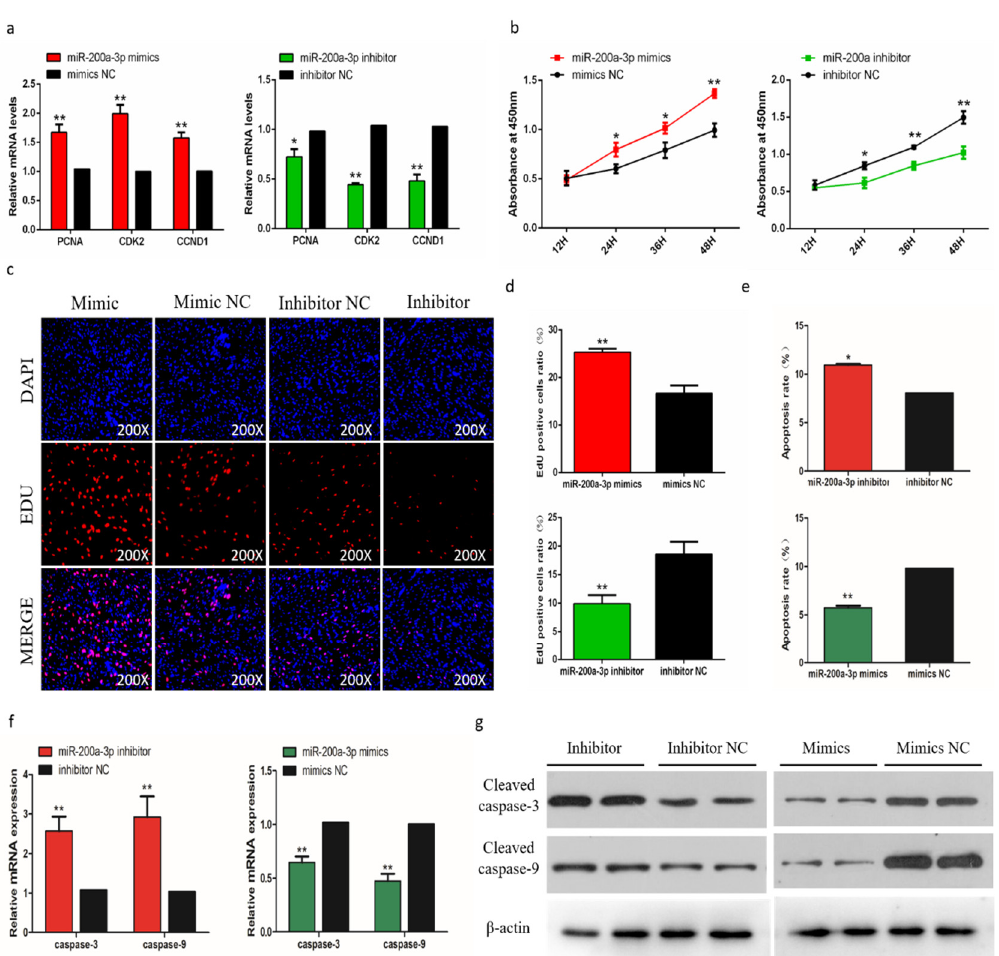
Figure 6. E ff ects of miR-200a-3p on the apoptosis of skeletal muscle satellite cells (SMSCs). ( a ) Detection of mRNA levels of SMSC cell proliferation-related genes after overexpression and inhibition of miR-200a-3p by qRT-PCR. ( b ) Cell Counting Kit-8 (CCK-8) detects SMSCs after overexpression and inhibition of miR-200a-3p. ( c , d ) EdU staining and chicken SMSCs proliferation rate after transfection of miR-200a-3p mimics and inhibitors in SMSCs. The results are shown as an average scanning electron microscope, and the data represent at least three independent analyses. Student’s t-test was used to compare the expression levels between groups. ( e ) Scattergram and the rate of apoptosis in SMSCs transfected with miR-200a-3p mimics or miR-200a-3p inhibitors as analyzed using flow cytometry following staining with annexin V and PI. ( f , g ) Abundance of mRNA and proteins of caspase-3 and caspase-9 in SMSCs transfected with miR-200a-3p inhibitors and miR-200a-3p mimics as determined by the use of qPCR and Western blot analysis. Data are expressed as mean ± SEM ( n = 3). * p < 0.05; ** p < 0.01 vs. NC.